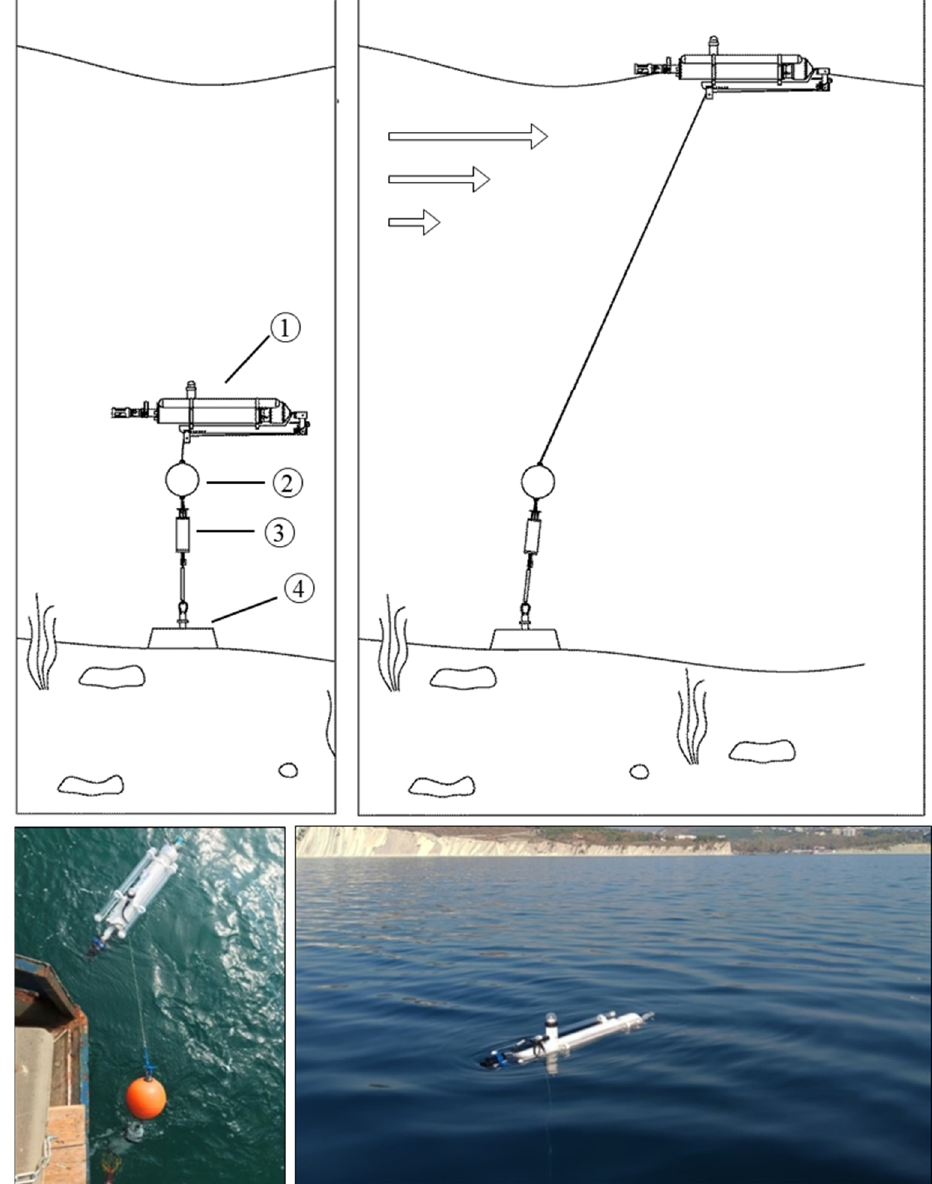
Figure 11. Upper part —Schematic of the profiler mooring system. Top left —The profiler at the parking position: (1)—the profiler Winchi, (2)—flotation, (3)—acoustic release, and (4)—anchor. Top right —The profiler after ascent to the sea surface. Lower part —Sea trials near Blue Bay in the Northeastern Black Sea. Bottom left —Deployment of the profiler Winchi mooring system. Bottom right —The profiler on the sea surface.